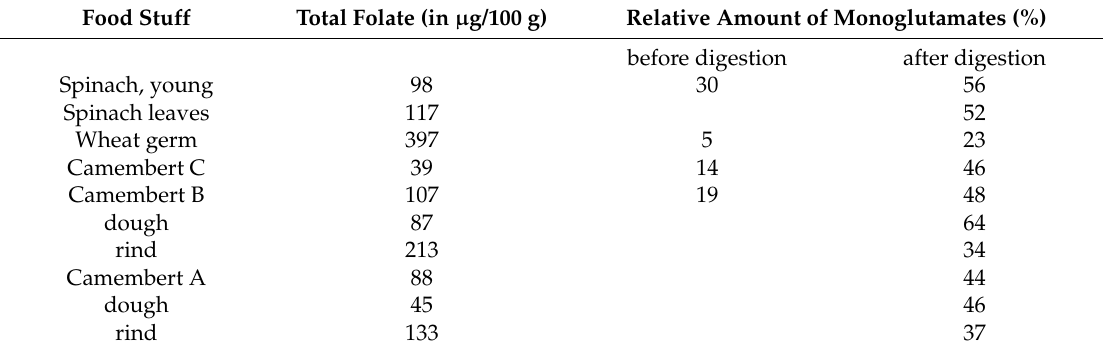
Table 2. Deconjugation efficiency for different foodstuffs, using the same lot of scraped brush border membrane (mucosa from a pig’s small intestine).